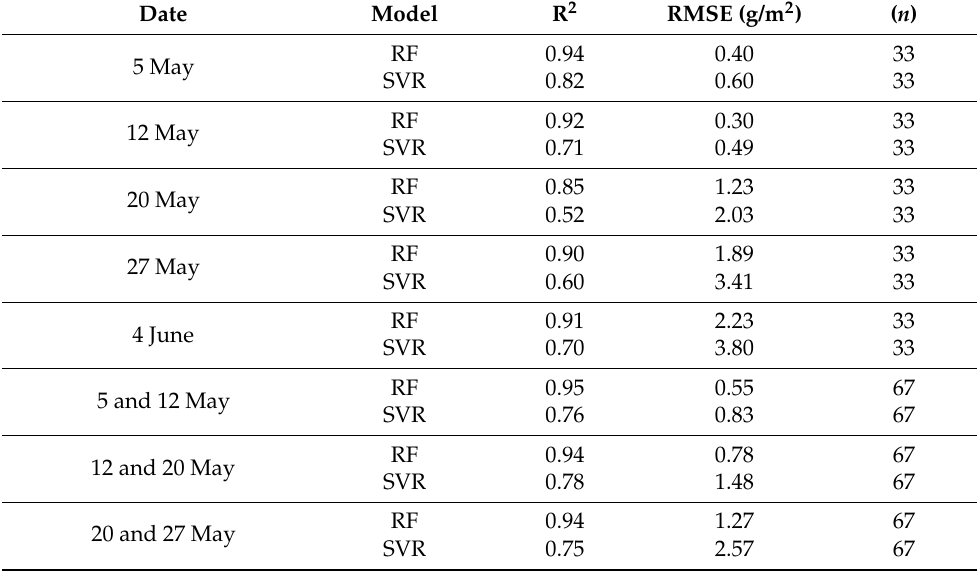
Table 7. Statistics for the calibration of the PlanetScope canopy nitrogen models with 24 variables as a function of the date and the modelling approach (RF or SVR) 1